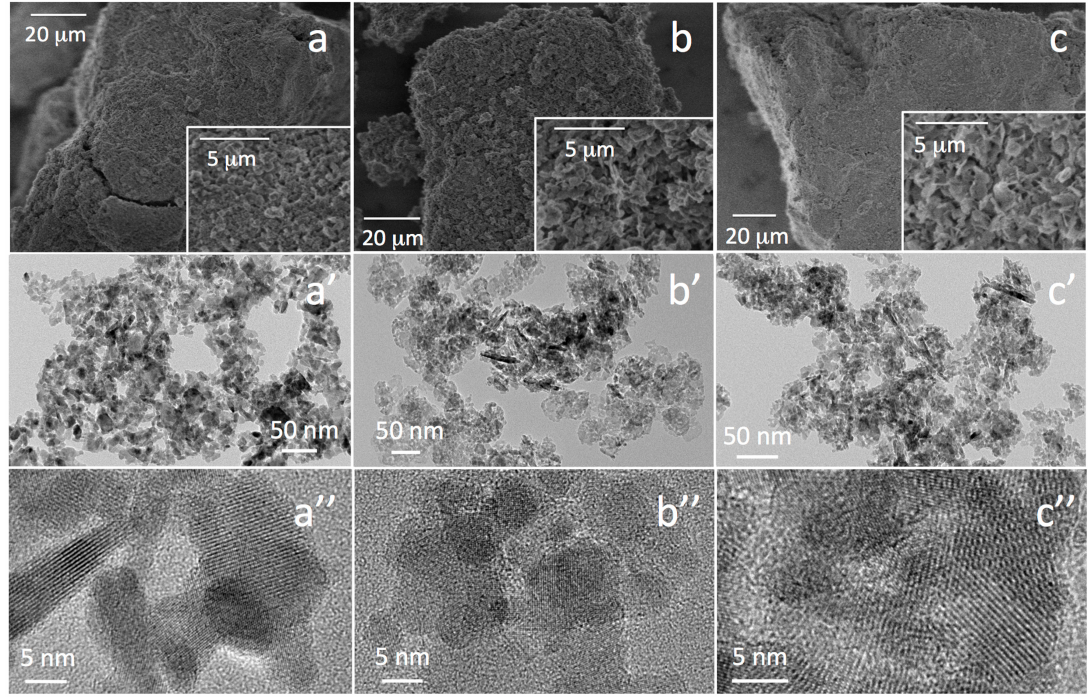
Figure 3. ( a – c ) SEM; ( a ' –c ' ) TEM and ( a '' – c '' ) HR-TEM images of samples of ( a , a ' , a ''